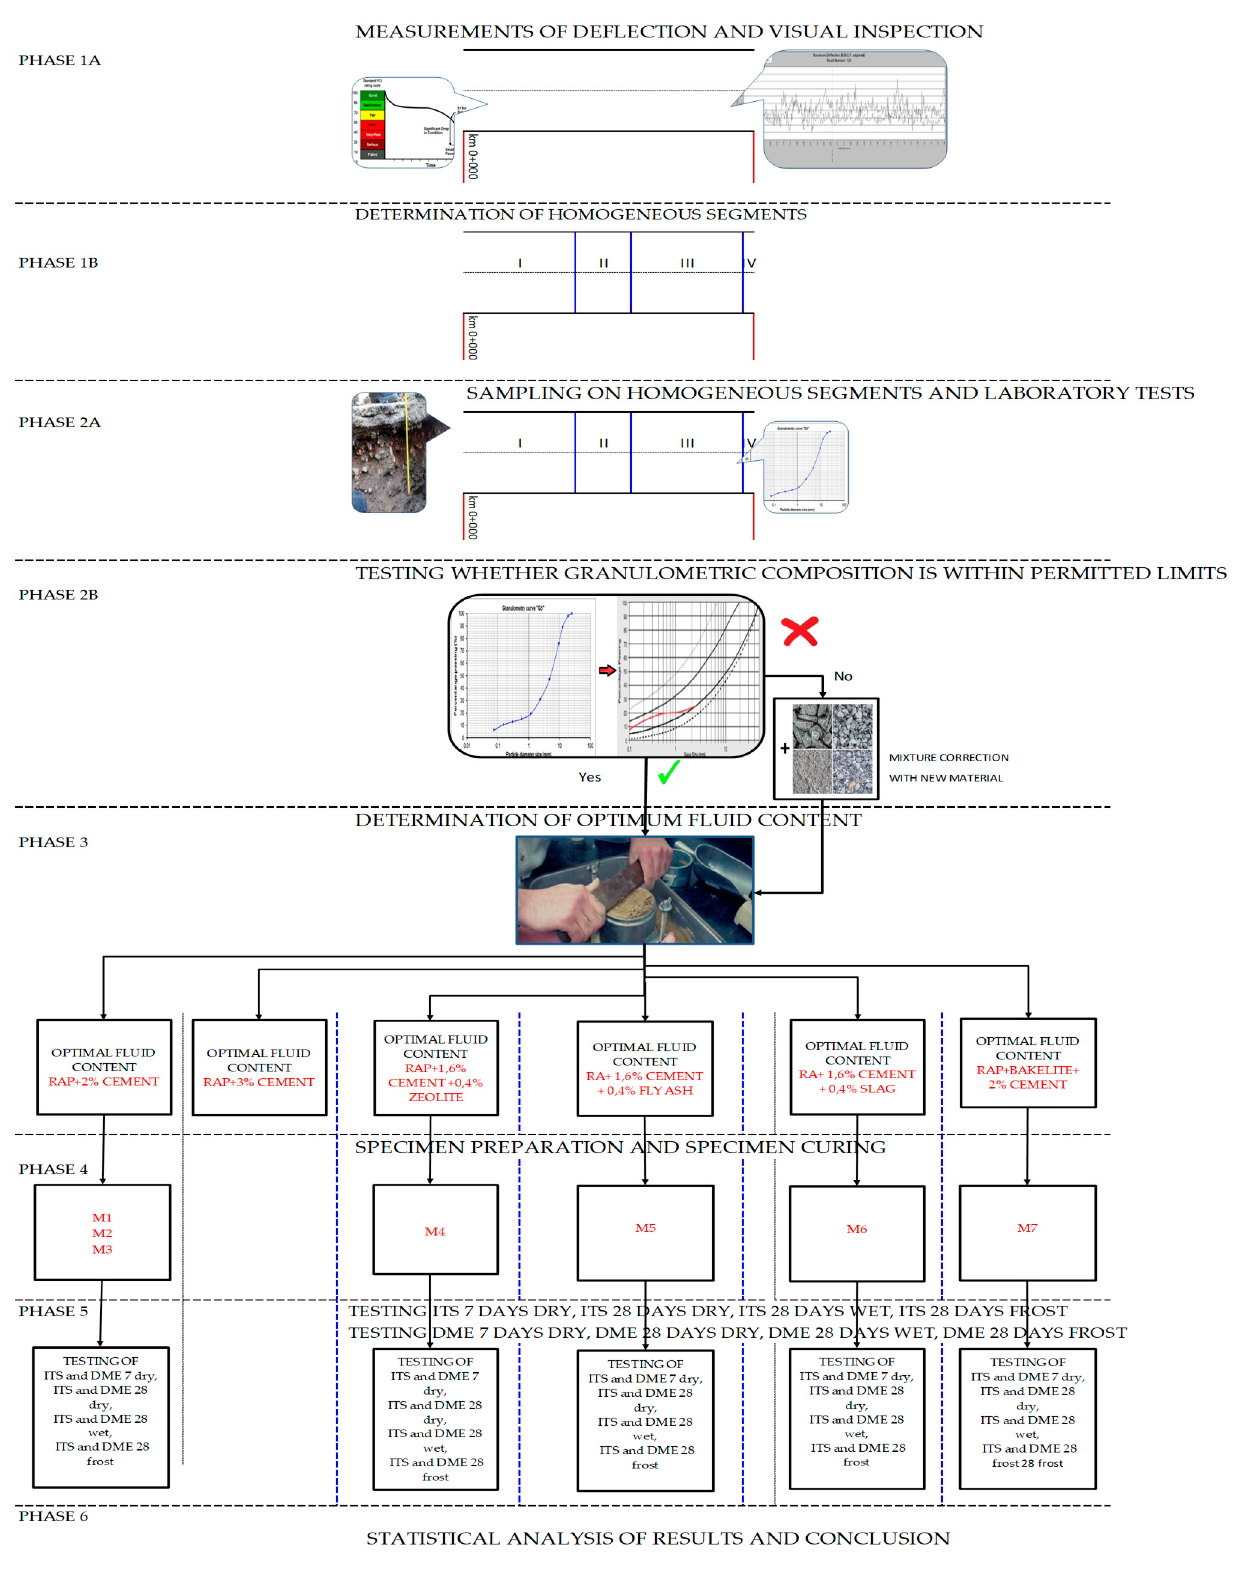
Figure A1. Research flow diagram.